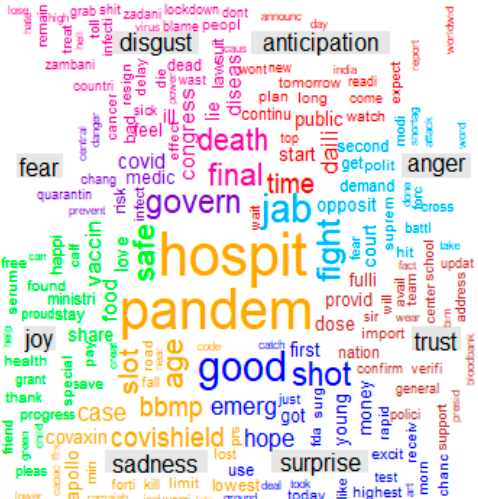
Figure 4. Wordcloud of emotions during infectious disease in June 2021.